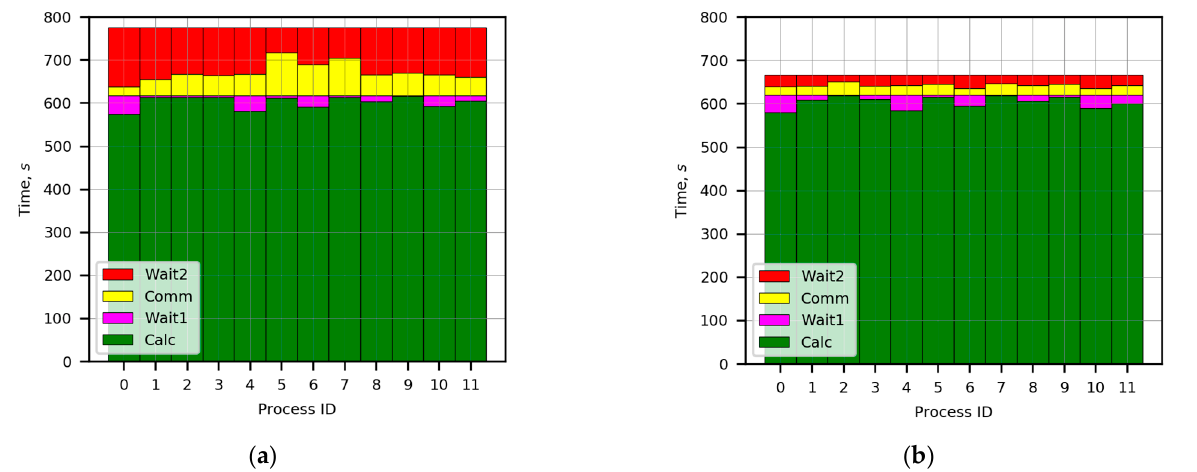
Figure 6. Contribution of computation, communication, and waiting to the benchmark time ( p = 12): ( a ) default and ( b ) improved mapping of subdomains to processes.